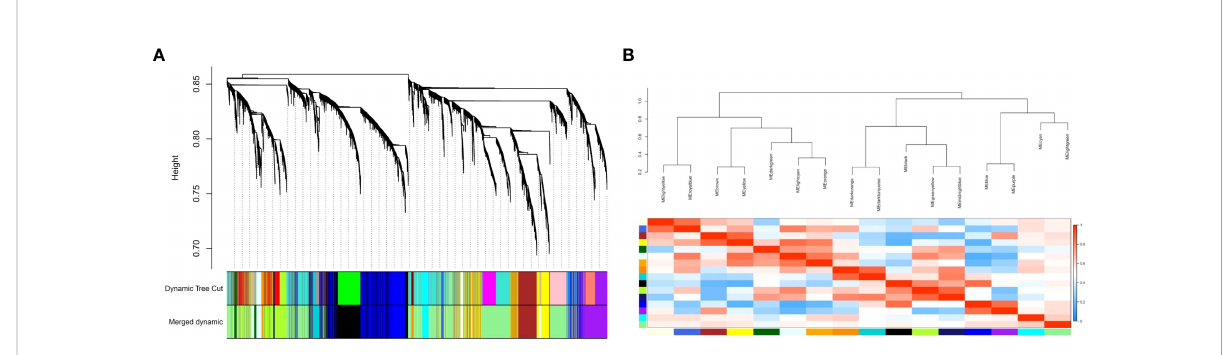
FIGURE 2 (A) The cluster dendrogram and modules before and after merging. The branches of the dendrogram cluster demonstrate the compact interconnected and also highly co-expressed genes; (B) The merged modules and their correlations. Each color demonstrates an individual